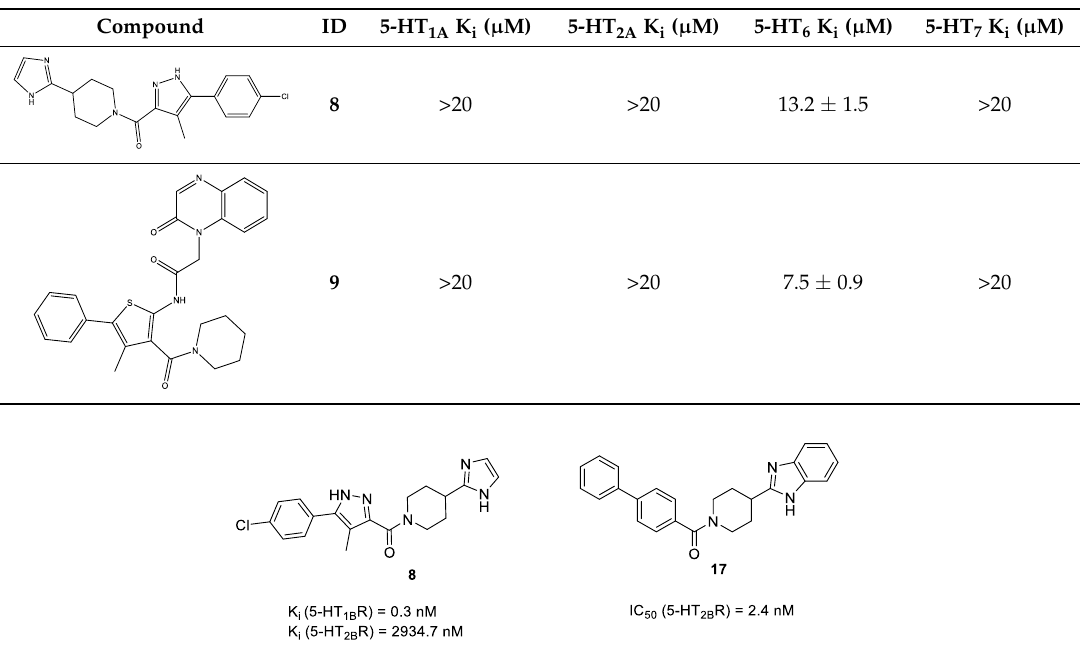
Figure 6. Structure of hit compound ( 8 ) and its closest literature analogue ( 17 ).